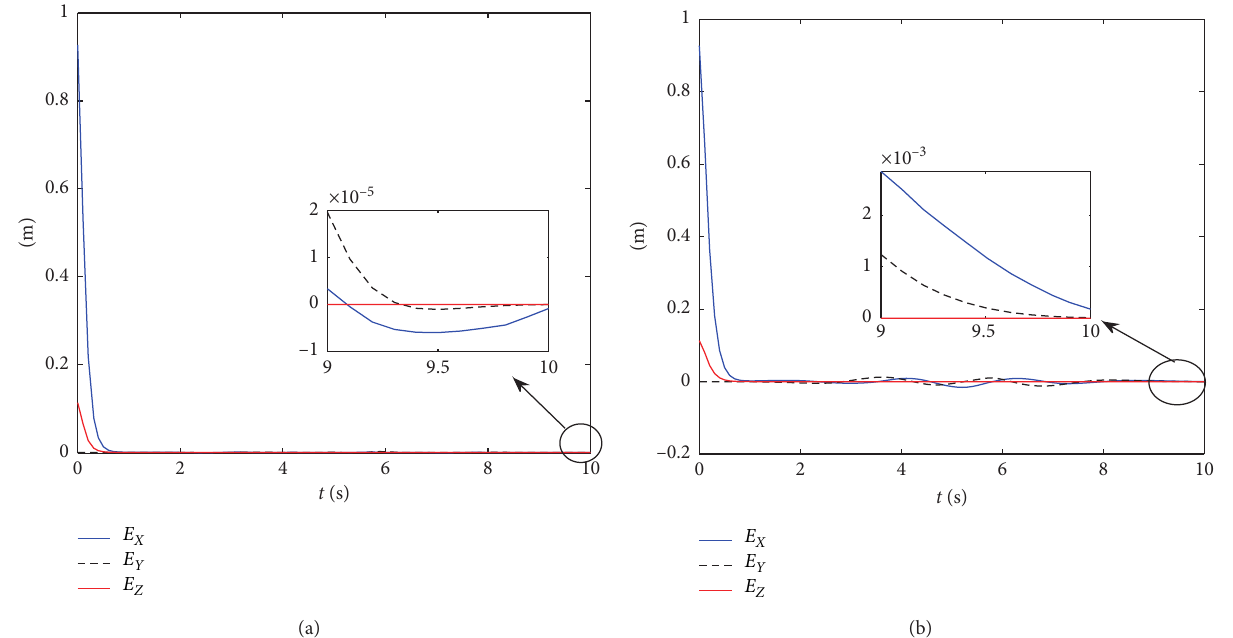
Figure 4: Synthesized positioning errors of the end effector by the EVPNN model and ZNN model when completing the task of the star- shaped path. (a) EVPNN model. (b) ZNN model.